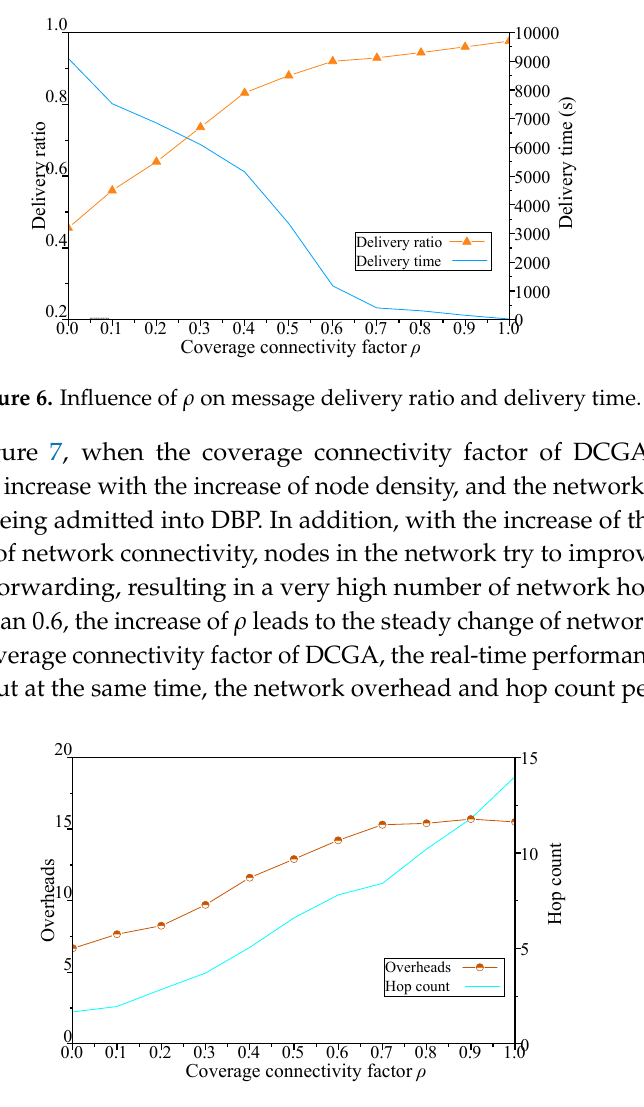
Figure 5. Influence of ρ on network connectivity probability and number of nodes.